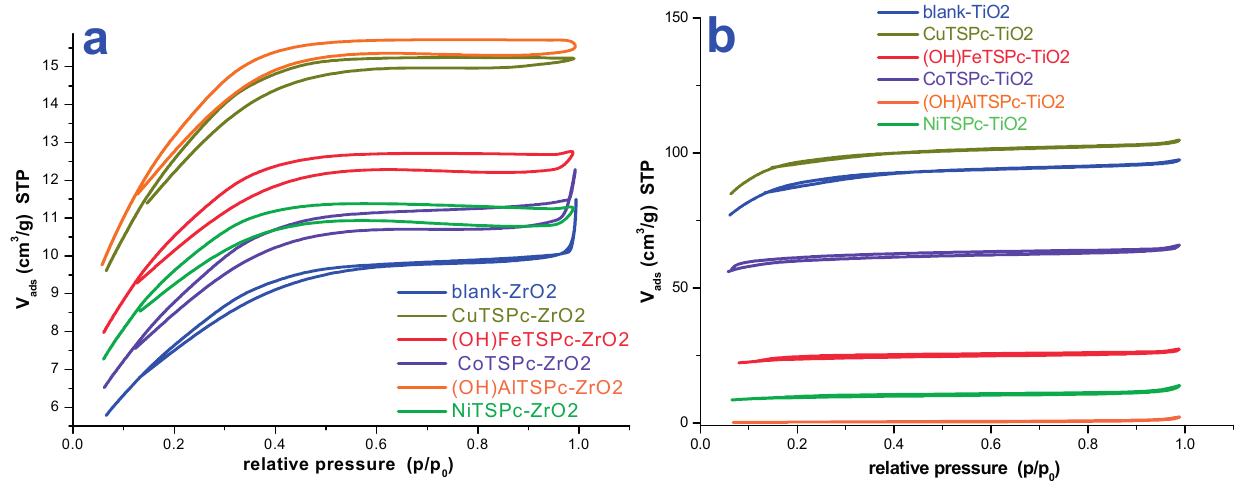
Figure 9. N2 sorption-desorption isotherms (at 76 K) on: ( a ) ZrO 2 and ( b ) TiO 2 xerogels containing the different MTSPc species trapped inside the pore network.